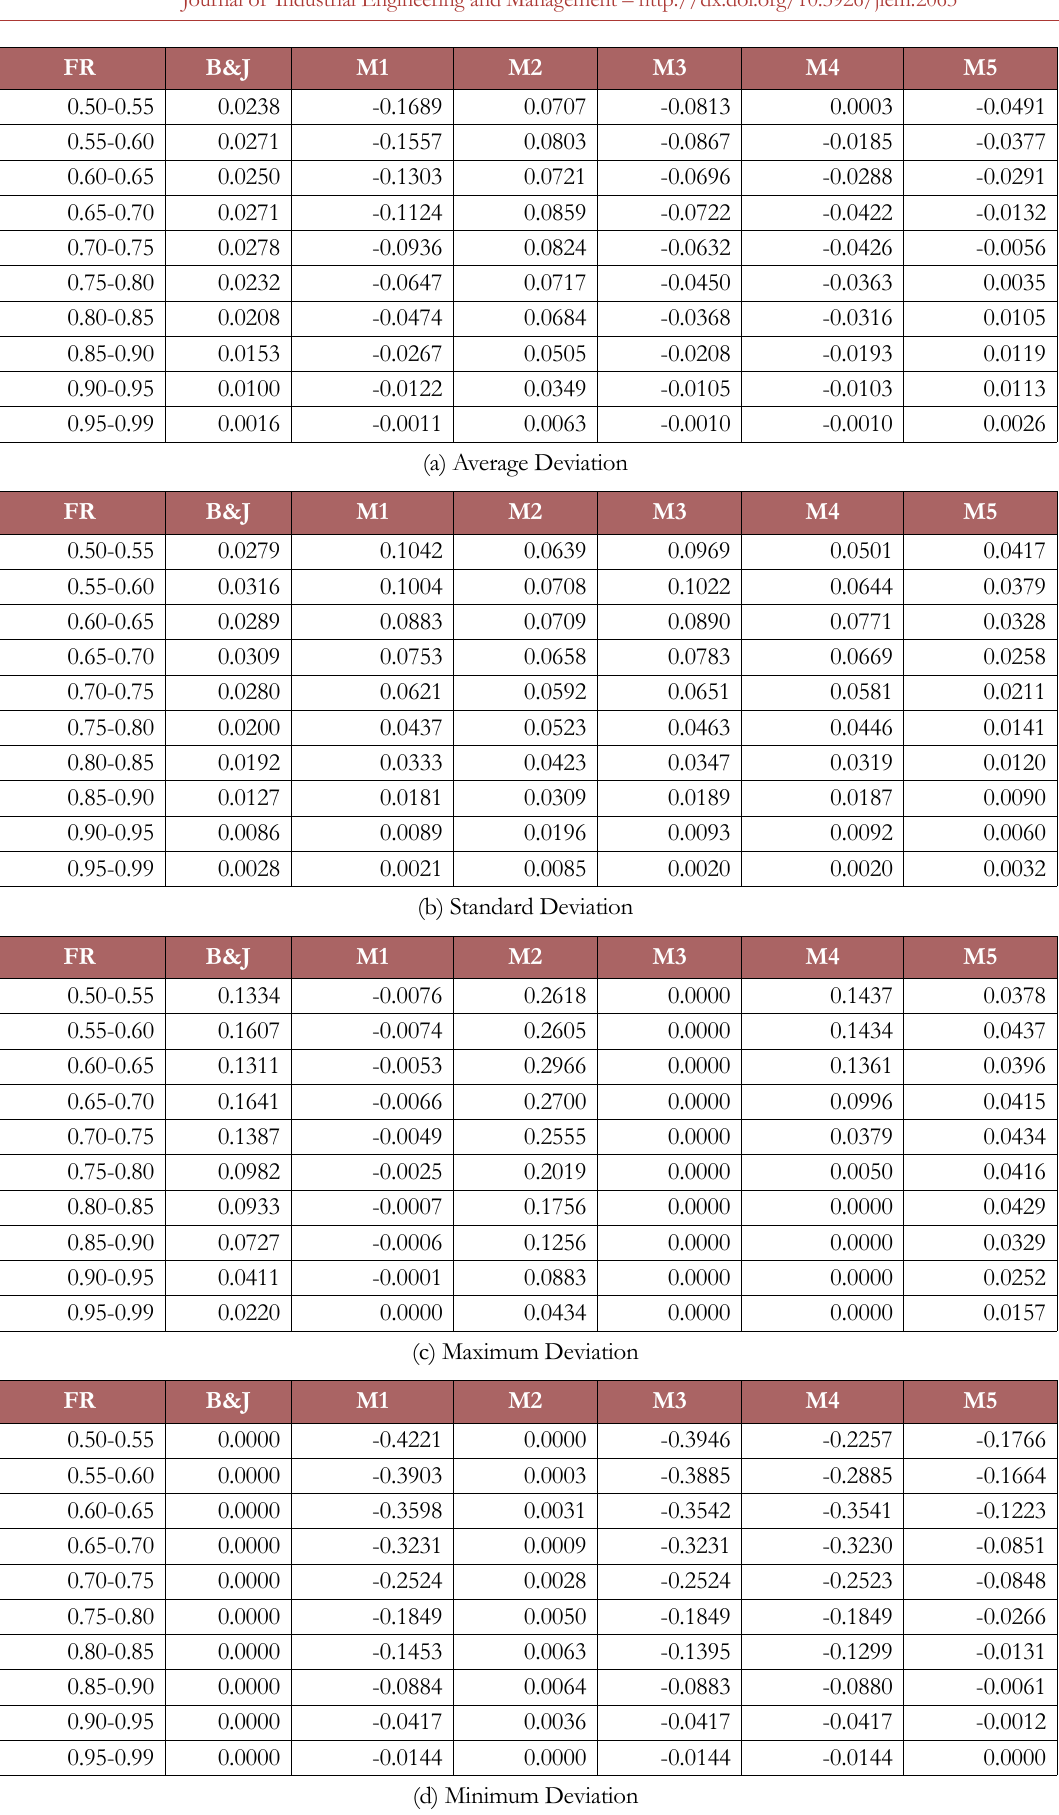
Table 2. Deviations of the estimation